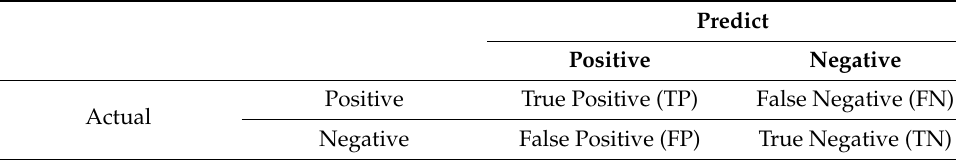
Table 4. Confusion